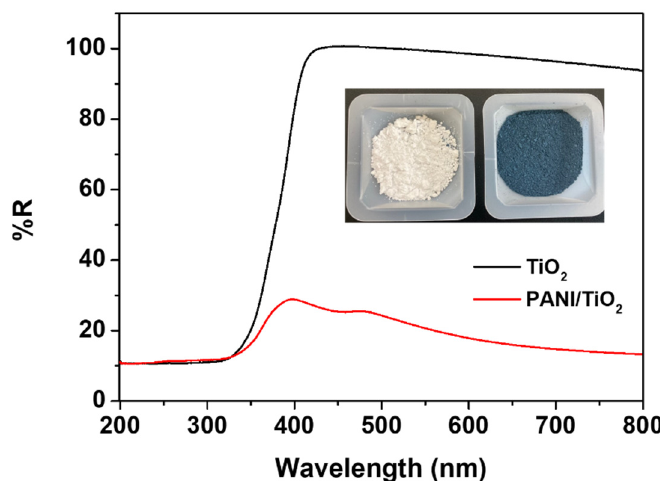
Figure 4. X-ray di ff raction (XRD) pattern of PANI / TiO 2 composite. Figure 4. X-ray diffraction (XRD) pattern of PANI/TiO 2 composite.